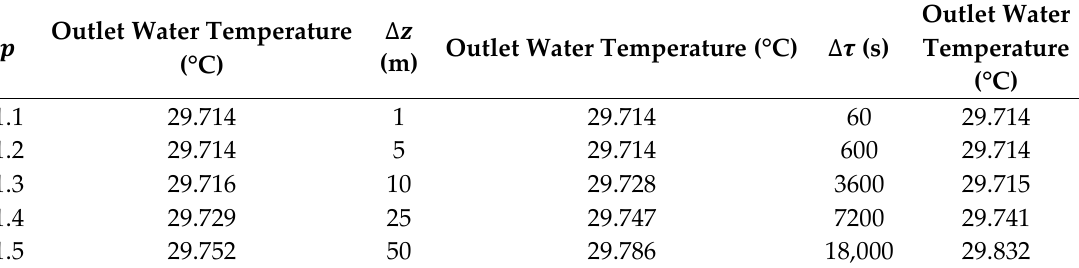
Table 4. Mesh independence analysis on space steps and time